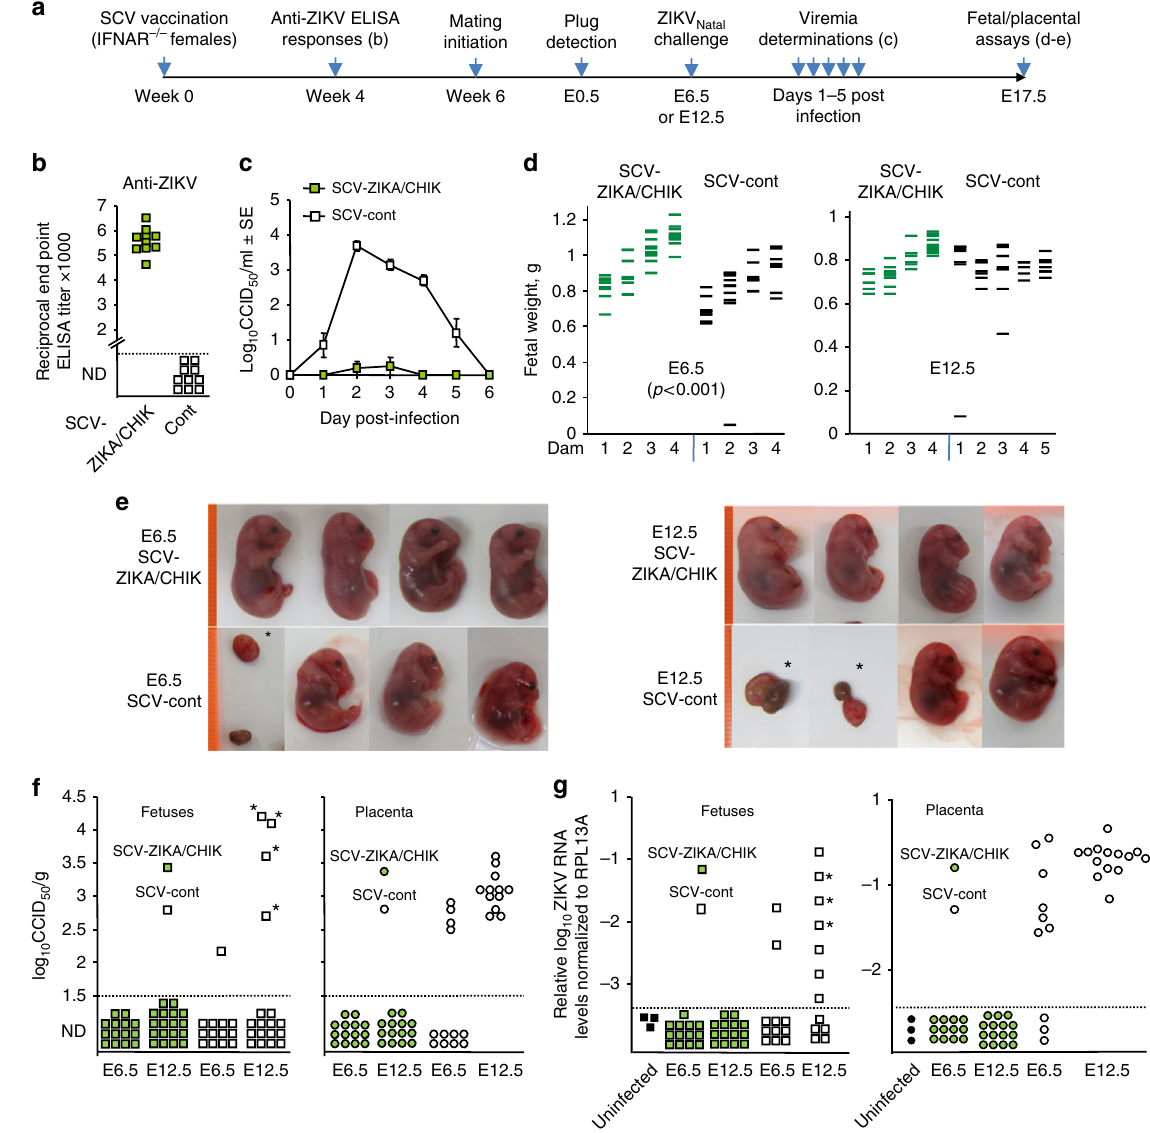
Fig. 4 Challenge of vaccinated pregnant IFNAR − / − dams with ZIKV Natal . a Timeline of vaccination, antibody responses, mating, challenge, viremia, and fetal/placental assays. b Anti-ZIKV serum IgG ELISA titers 4 weeks after vaccination with SCV-ZIKA/CHIK or SCV-cont; ( p < 0.001 Kolmogorov – Smirnov tests). c Viremia in the vaccinated mice ( n = 10 per group). (For days 2 – 4 all p < 0.001, Kolmogorov – Smirnov tests). Error bars represent standard error of the mean. d Fetal weights at E17.5 for SCV-vaccinated dams ( n = 4 – 5 dams per group) infected with ZIKV Natal either at E6.5 or E12.5 (for fetuses n = 36, 33, 35, 43 left to right). SCV-cont vaccinated dams had a lower mean fetal weight than SCV-ZIKA/CHIK vaccinated dams when challenged at E6.5 ( p < 0.001, t test, n = 36 and 33). Fetal/placental masses were not included in this graph. e Photographs of selected fetuses (E17.5). Highly deformed fetuses and placenta, and fetal/placental masses are indicated by asterisks (*). The orange lines on the left represent a ruler with 1 mm marks. f Fetal and placenta ZIKV tissue titers at E17.5 from SCV-vaccinated dams (at least three fetal/placental tissues from each of the 4/5 litters were tested); fetal heads or placenta, except * indicating deformed fetal/placental masses. Limit of detection was 1.5 log 10 CCID 50 /g. The positive placenta in SCV-cont E6.5 group were derived from three litters. Titers were signi fi cantly lower in the SCV-ZIKA/CHIK vaccinated groups compared to the SCV-cont groups p < 0.001 (Kolmogorov – Smirnov test) combining data from F and Pl, and E6.5 and E12.5. g qRT PCR of fetal heads. Three uninfected fetal heads (black squares) were analyzed in triplicate and the highest value plus 3 SD was used as a cutoff (all other data points below the dashed cutoff line are not plotted to scale). *Deformed. Statistics as for f , p = 0.001 combining data from E6.5 and PCR (Fig. 1f) and quantitative PCR (Fig. 1g). The correct size of in SCV-ZIKA/CHIK-infected HeLa cells was not lower than in (i) the CHIKV structural protein insert into the A39R locus, and SCV-CHIK 2 infected HeLa cells (Supplementary Fig. 1). (ii) the ZIKV prME insert into the B7R – B8R locus, was retained after 10 passages, with no evidence of deletions (Fig. 1f). In addition, quantitative PCR of ZIKV M protein DNA, normalized to the G1L gene of VACV 32 , showed no reduction in levels of M saged 10 times in SCS cells (MOI = 0.01 – 0.001, 3 day culture per protein DNA over 10 passages. passage), with virus from passage 1 and passage 10 analyzed by